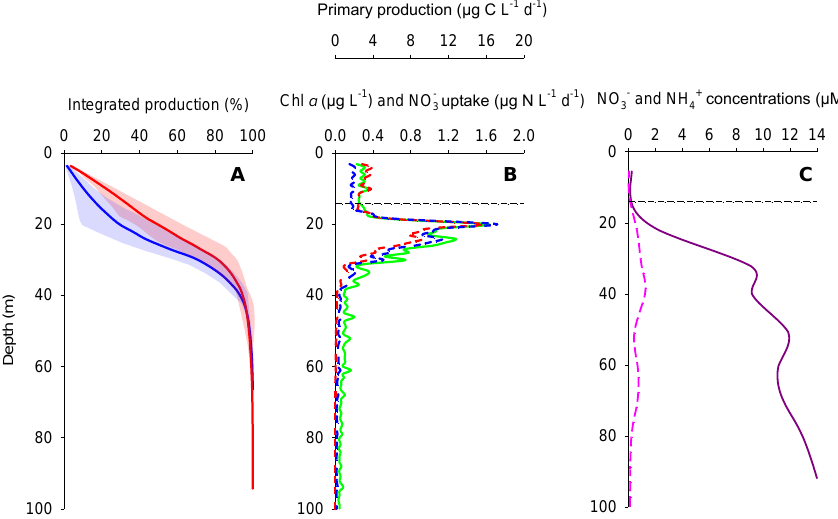
Fig. 3. Reconstructed profiles of (A) averaged integrated production (% of total water-column production; standard deviation delimited by the shaded areas) for C uptake (red) and N uptake (blue) for incubations performed simultaneously with surface and SCM samples, (B) chl a concentration estimated from post-calibrated in-vivo fluorescence (µgL − 1 ; solid green line) and primary production (µgCL − 1 d − 1 ; red dashed line) and NO − uptake (µgNL − 1 d − 1 ; blue dashed line) estimated from uptake-irradiance parameters and (C) NO − 3 line) and NH + (pink dashed line) concentrations (µM) for station 303 in 2006 (yellow arrow in Fig. 1; left-hand side). The black dashed line 4 marks the depth of the pycnocline